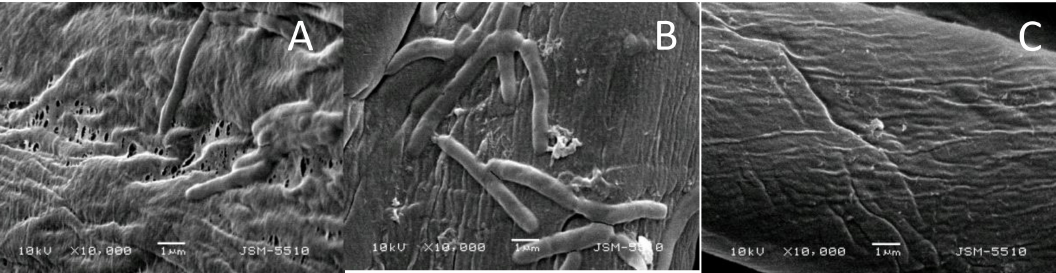
Figure 7. Scanning electron microscope (SEM) micrographs of cotton fabrics tested against B. cereus : cotton fabric before treatments ( A ), cotton fabric treated with BT ( B ), and cotton fabric treated with [Zn(BT)(NO 3 ) 2 ] ( C